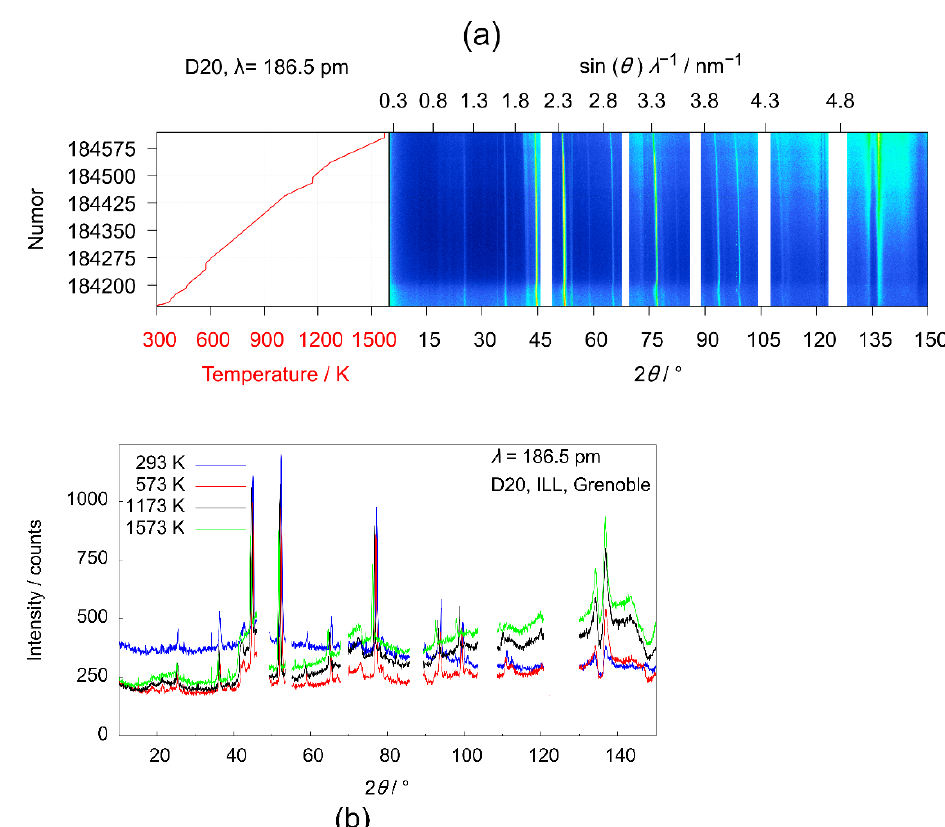
Figure 8. In situ powder neutron diffraction of Ba 2 In 1.8 Cr 0.2 O 5.3 (H 2 O) x in a dynamic vacuum ( p min ≥ 1.2 × 10 − 5 mbar). ( a ) temperature profile and diffraction data as a false colour plot; ( b ) comparison of the collected neutron diffraction data, number of run (Numor) 184142, 184244–184259, 184481–184496, 184604–184619, DOI: doi.org/10.5291/ILL-DATA.5-24-640.